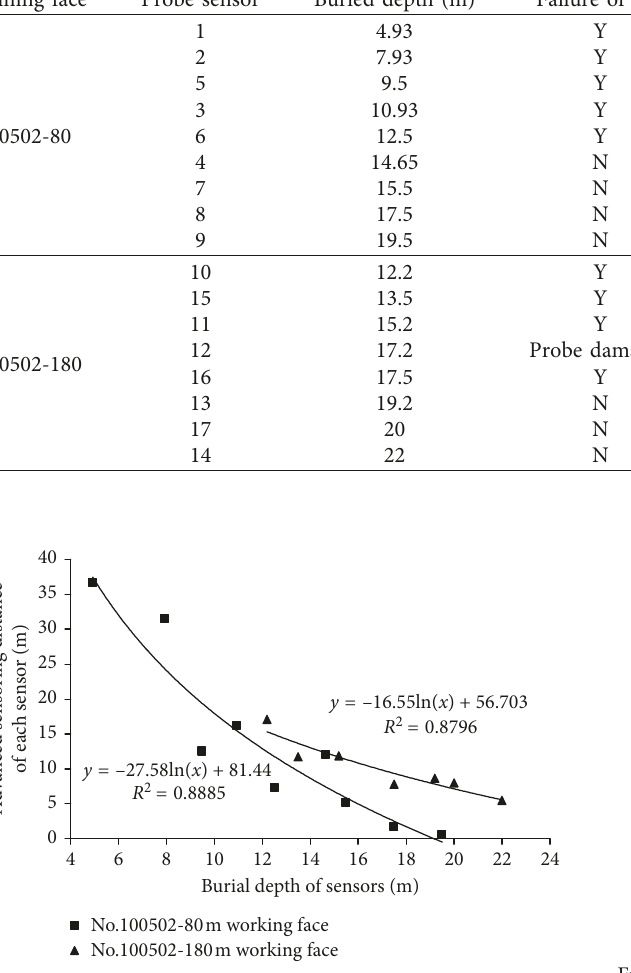
Table 2: Failure and damage characteristics of the floor rocks at the buried locations of each probe sensor. Mining face